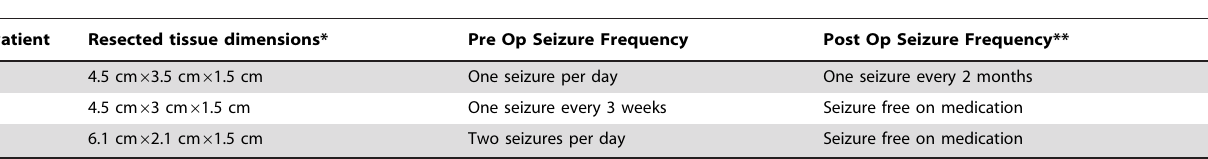
Table 3. Surgical Resection & Seizure